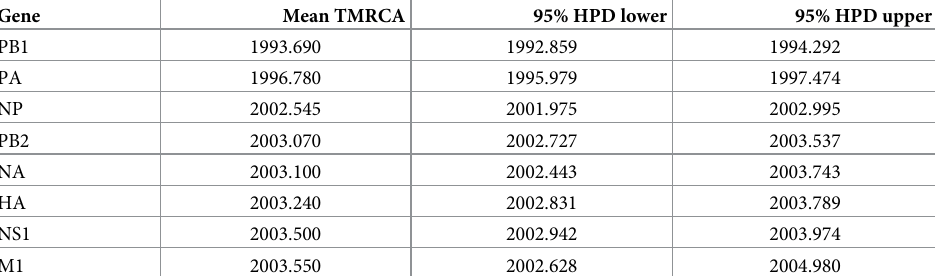
Table 1. Estimated time of most recent common ancestor (TMRCA) for Yamagata-lineage clade 2 and clade 3